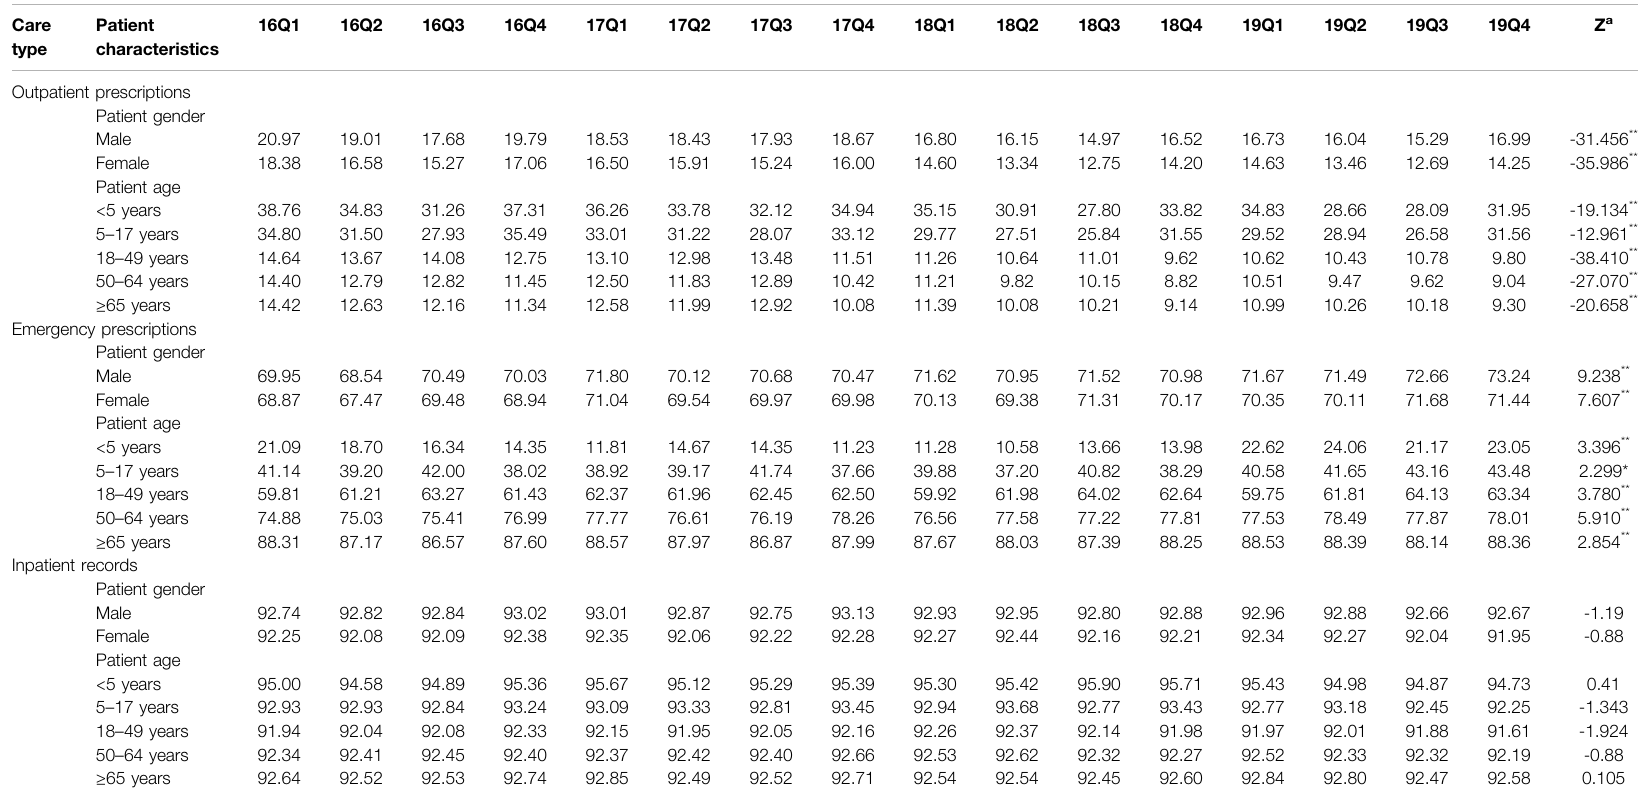
TABLE 7 | Changes in proportion of prescribed with parenteral antibiotics by patient characteristics, 2016 – 19. Care